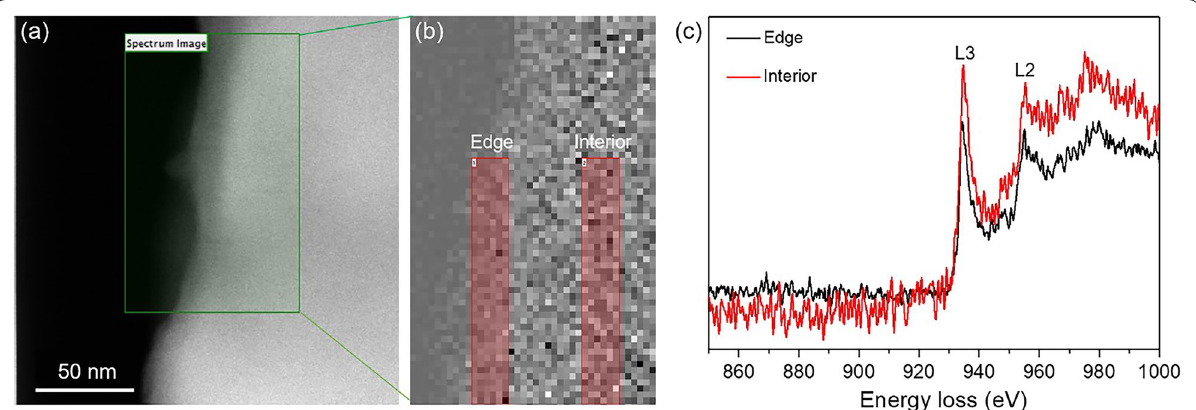
Fig. 5 a HAADF-STEM micrograph of 5DPT Cu 2 O, with the regions marked in ( b ) where EELS spectra were recorded. c EELS spectra of Cu L2, L3